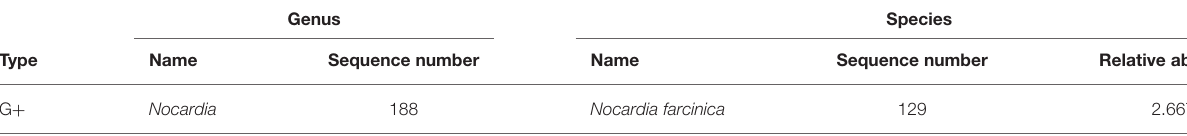
TABLE 1 | Pathogenic microorganism identified in blood sample.